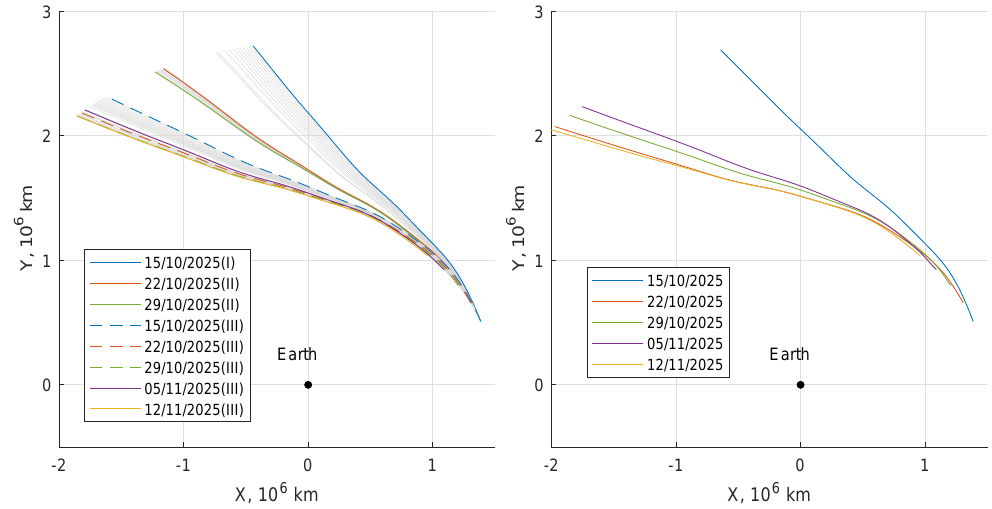
Figure 9. SEL2 escape trajectories over a lunar month—fixed C 3 = 0.2 (km/s) 2 ( left ), 0.5 (km/s) 2 ( right ), free t f , EME2000